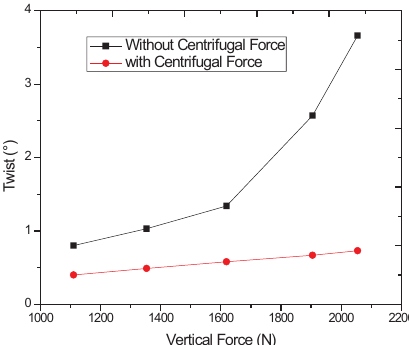
Figure 14. Span wise force vs. axial deformation